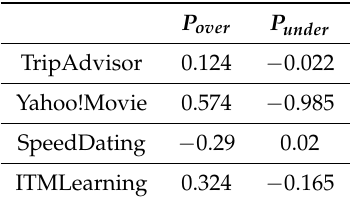
Table 4. Learned